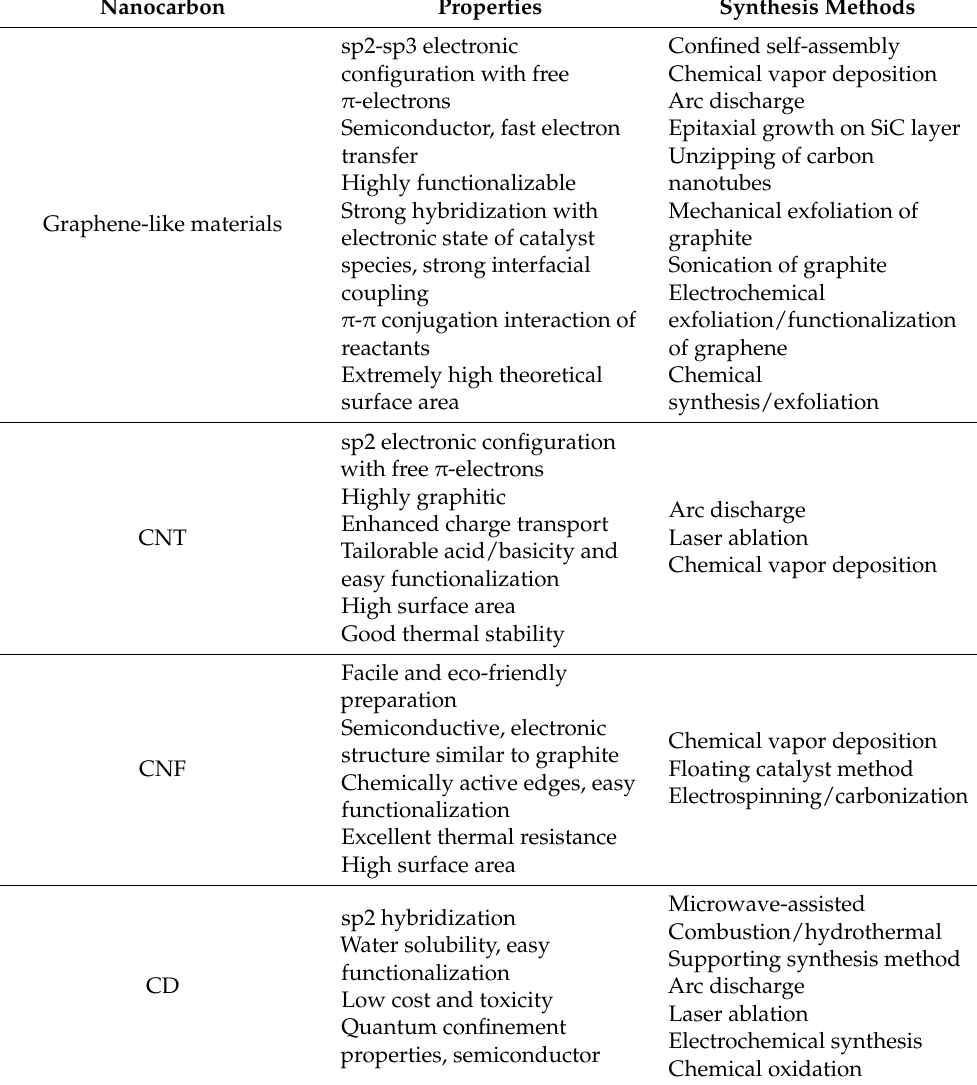
Table 1. Properties and synthesis methods of different types of